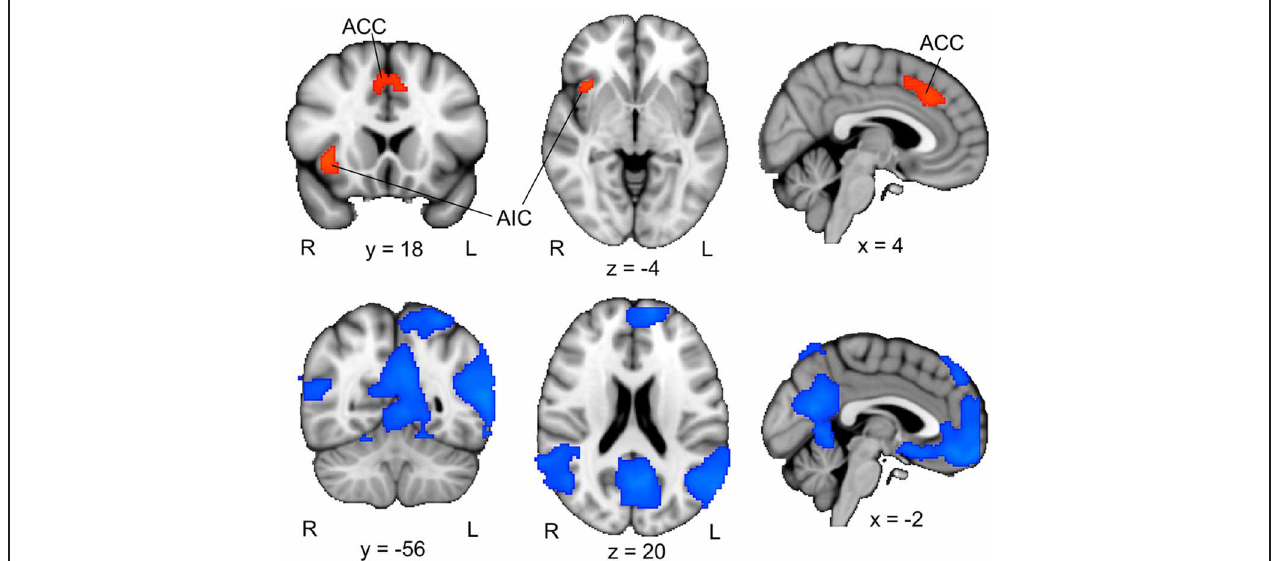
FIGURE 2 | ACC/AIC activation associated with perceptual uncertainty. Upper panel: The colored regions were more active when the first picture in a trial was blurred (i.e., the first pictures in the B–C corresponding and B–C unrelated conditions) than when it was clear (i.e., the first pictures in the C–C and C–B conditions). R = right; L = left; ACC = anterior cingulate cortex; AIC = anterior insular cortex. The displayed activations